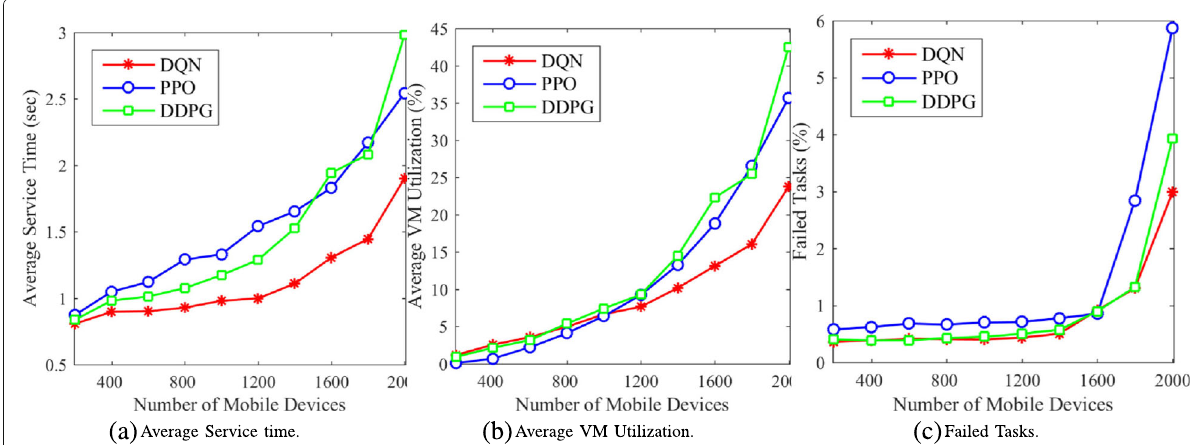
Fig. 3 Comparison of the three aspects: a Average Service Time. b Average VM Utilization. c Failed